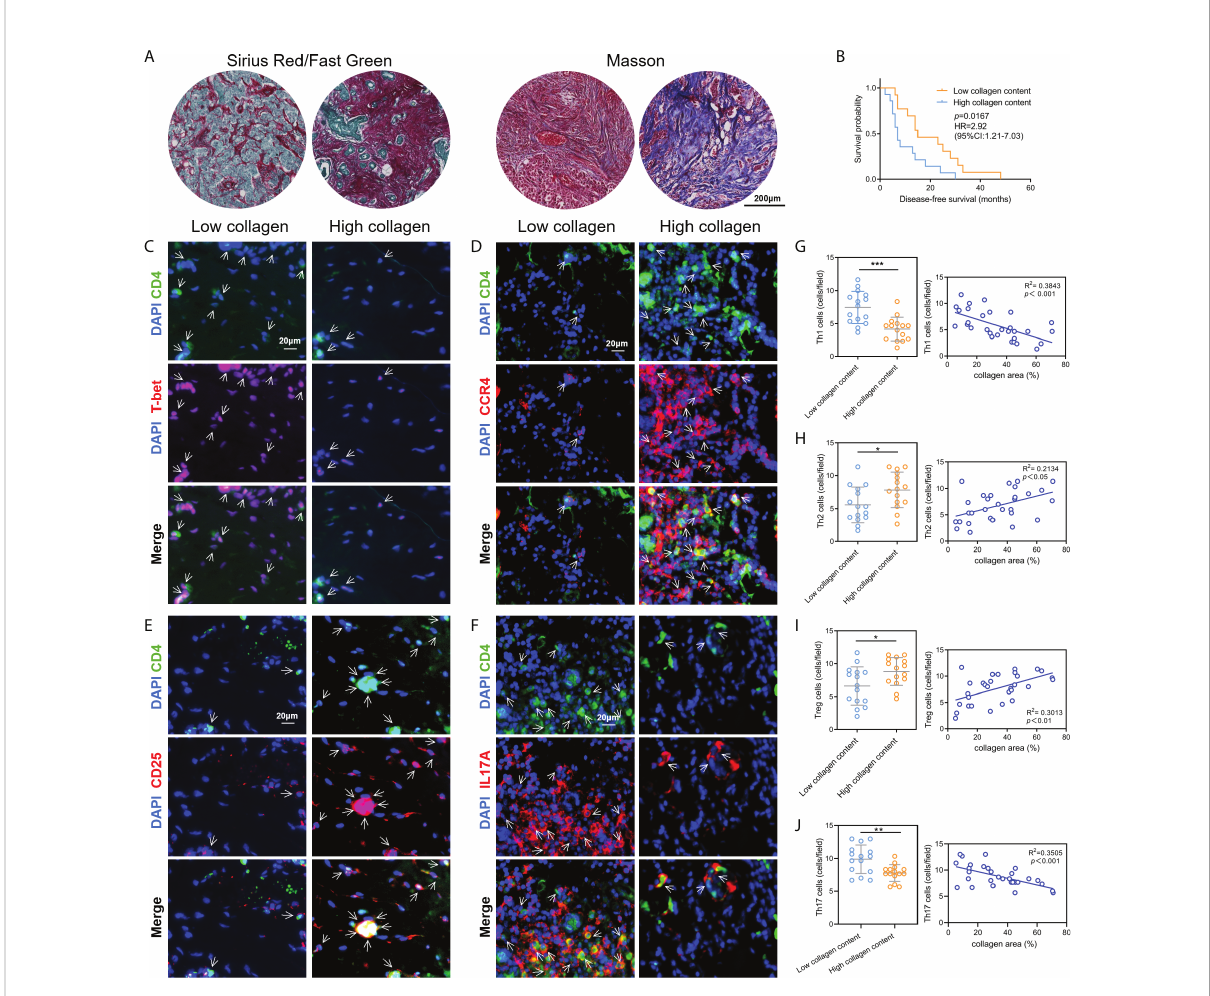
FIGURE 3 Validation of the correlation between ECM characteristics and Th cell in fi ltration by clinical tissue samples. (A) Measurements of collagen contents in breast cancer tissues by Sirius red staining and Masson staining. (B) Kaplan-Meier survival analysis revealed the DFS differences in breast cancer patients with different collagen contents. C-F. Tissue immuno fl uorescence staining showed the contents of Th1 (C) , Th2 (D) , Treg (E) and Th17 (F) cells in breast cancer tissue samples. G-J. Contents of Th1 (G) , Th2 (H) , Treg (I) and Th17 (J) in breast cancer tissues with different collagen abundances, and the corresponding correlation analysis between collagen abundances and Th cell contents. DFS, diseases- free survival; * p <0.05; ** p <0.01; *** p